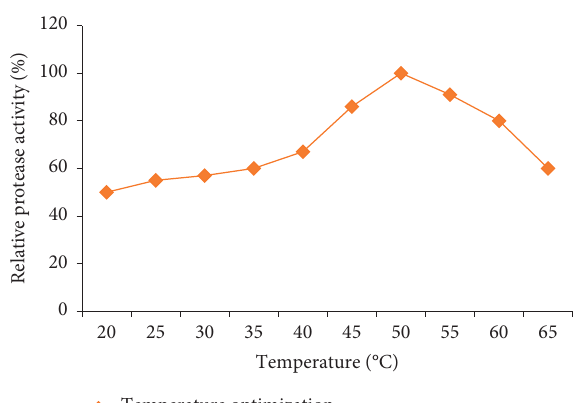
Figure 11: pH optimization of PA for acetone-precipitated enzyme from the isolate Z1BL1.